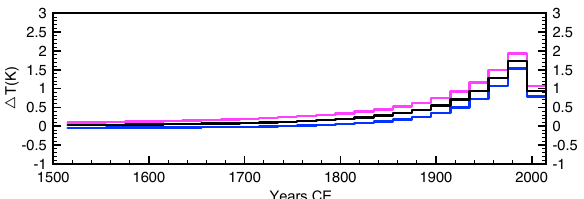
Figure 7. GST history for Totoral (RC370), with three eigenvalues retained. The pink and blue lines represent the inversion of the upper and lower bounds of the temperature anomaly or the extremal steady states.